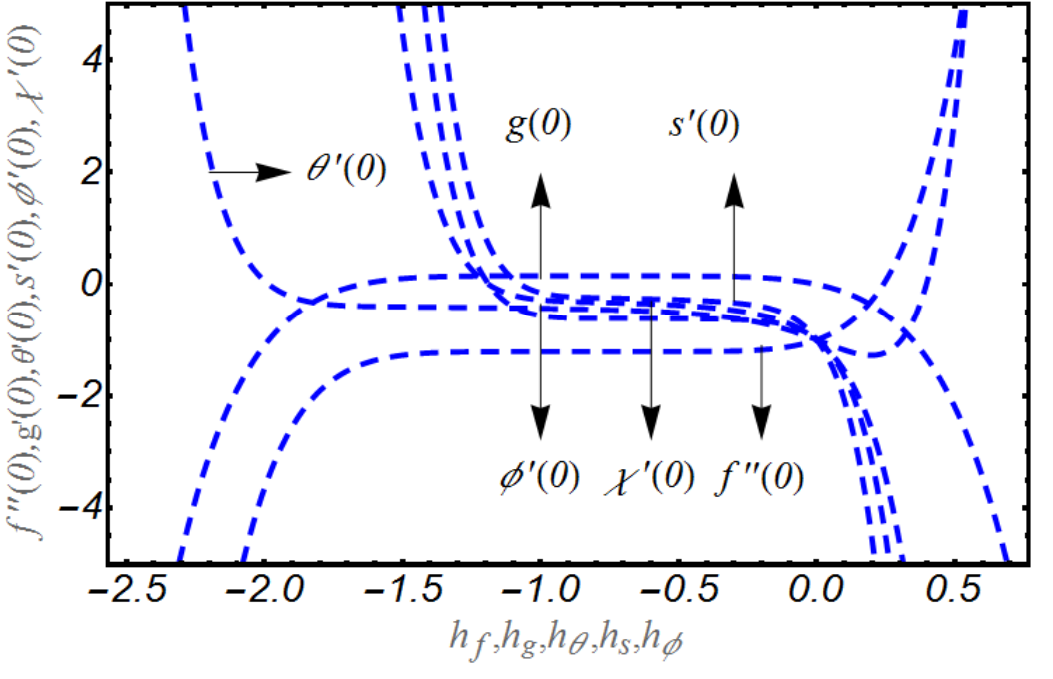
Figure 1. Curves for f (cid:48)(cid:48) ( 0 ) , g (cid:48) ( 0 ) , θ (cid:48) ( 0 ) , s (cid:48) ( 0 ) , φ (cid:48) ( 0 ) and χ (cid:48) ( 0 ) . Figure 1. curves for